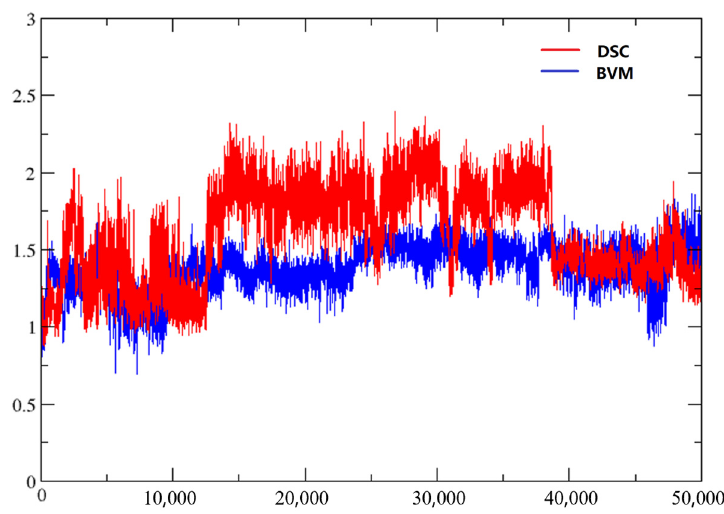
Figure 6. Variations of RMSD values in MD simulations of BVM and DSC.